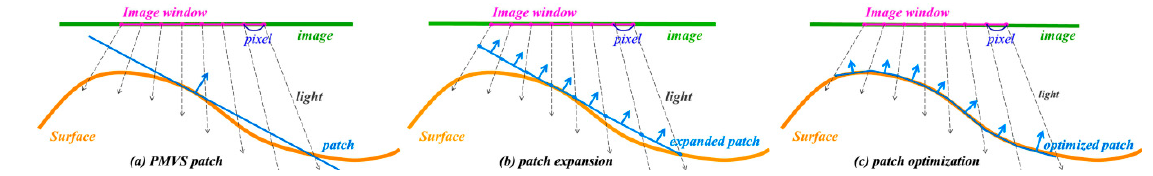
Figure 1. Diagrammatic sketch of the multi-view dense point cloud generation algorithm. ( a ) The result of the seed patch generated from PMVS; ( b ) The expanded patch from the PMVS patch; ( c ) The optimized patch to improve accuracy.